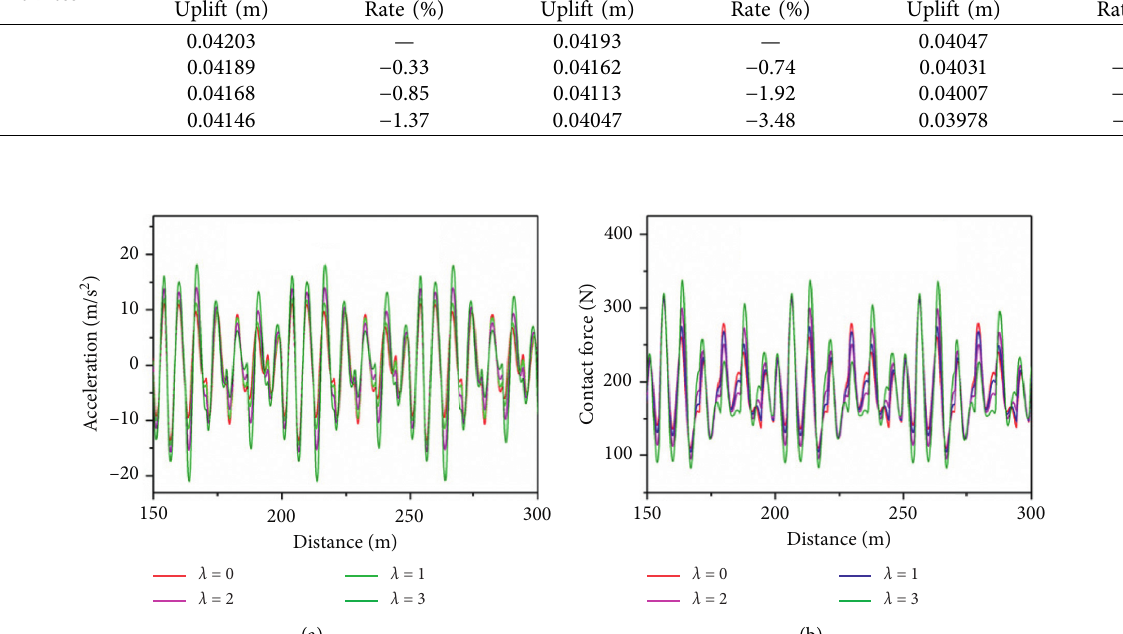
Figure 9: Dynamic characteristics between pantograph and catenary (Uniform Load Method). (a) Acceleration. (b) Contact force.